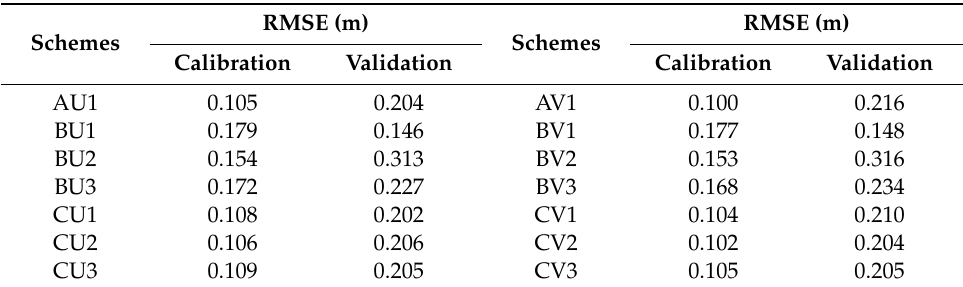
Figure 5. Statistical metrics of model performance in terms of RMSE at three in-situ stations for configuration A and B. ( a , b ) indicate results during the calibration and validation periods, respectively.